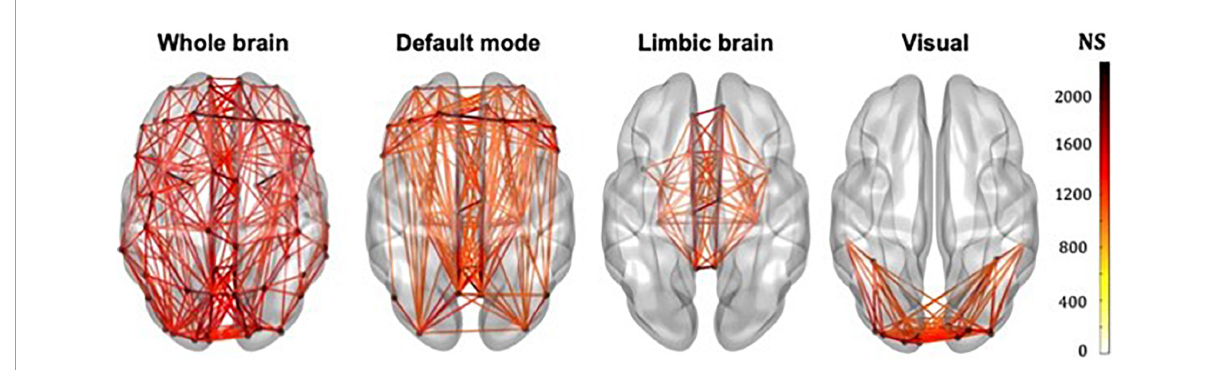
FIGURE3 Whole-brain, DMN, limbic and visual subnetworks, for NS-weighted networks, from the data of one participant. The lines represent the edges (connections) between brain